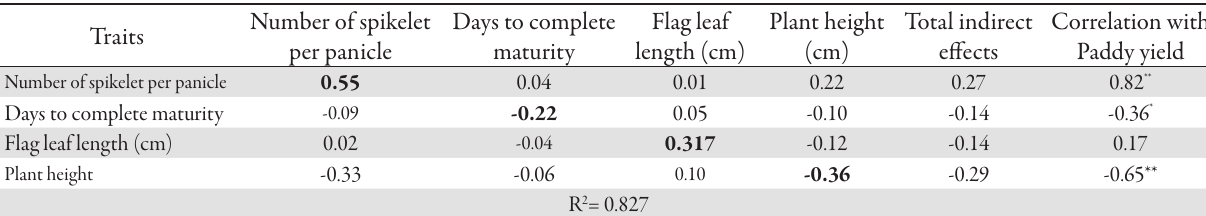
Tab. 7. Path analysis for paddy yield of 30 studied rice varieties under optimum irrigation regime. The bold values are direct